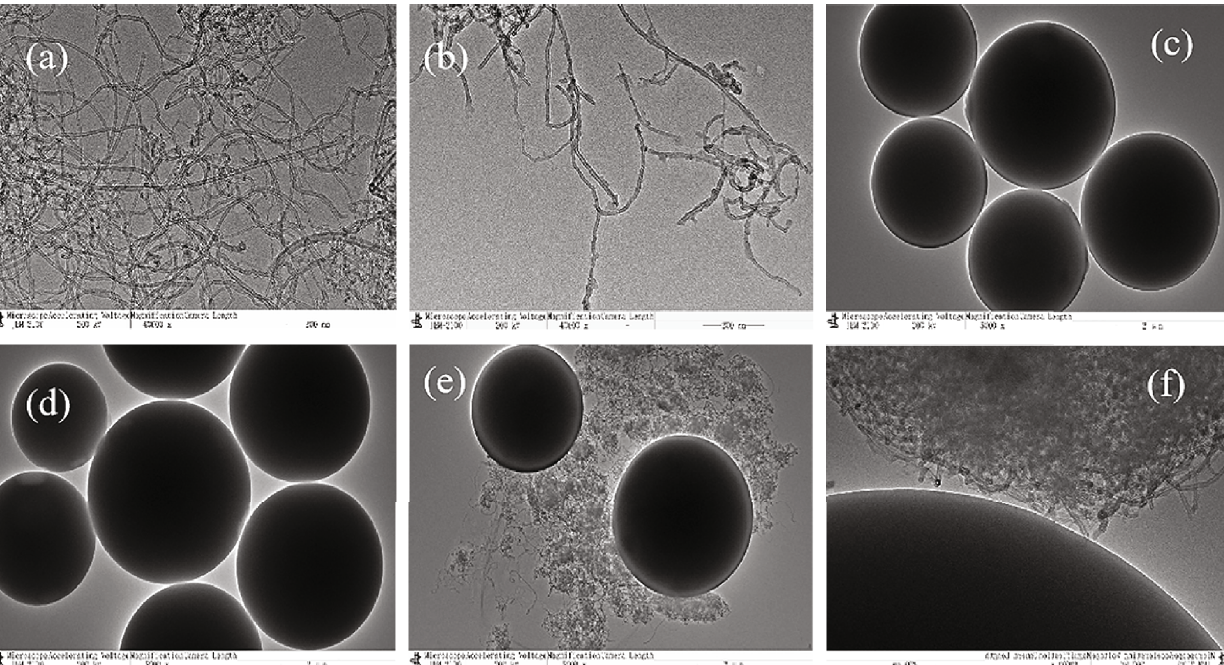
Figure 4: (a) TEM images of raw CNTs. (b) TEM images of CNTs-PDA. (c, d) TEM images of PSQ-SH particle. (e, f) TEM images of CNTs-